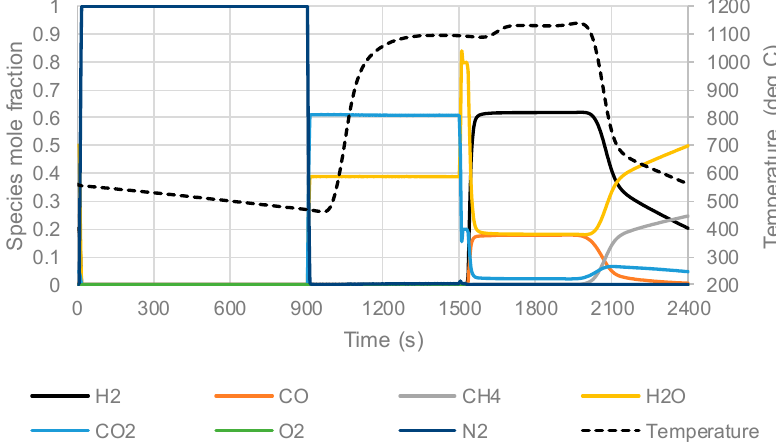
Figure 4. Outlet gas species composition and temperature during one PBCLR cycle.